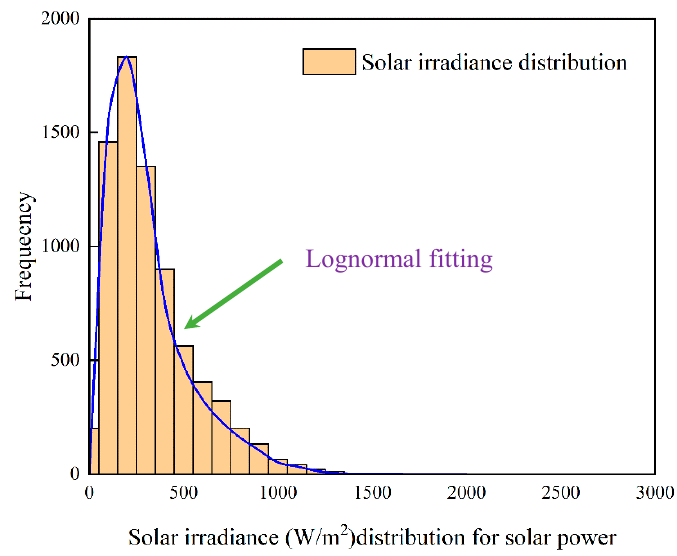
Figure 3. Solar irradiance (W/m 2 ) level through the Monte Carlo simulation.